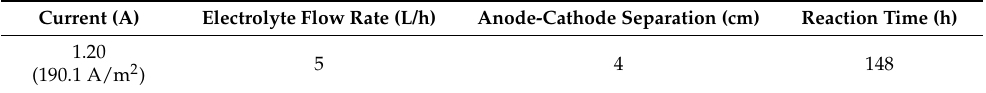
Table 2. Electrorefining